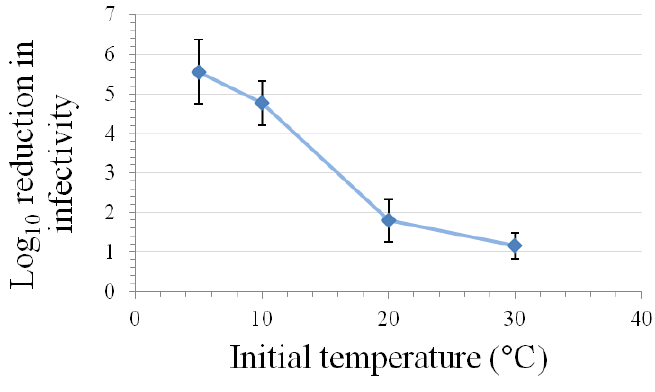
Figure 2. Effect of temperature on inactivation of MNV by a five-min high-pressure treatment at 350 MPa in a matrix of DMEM with 10% fetal bovine serum (mean ± SE, n = 9, modified from